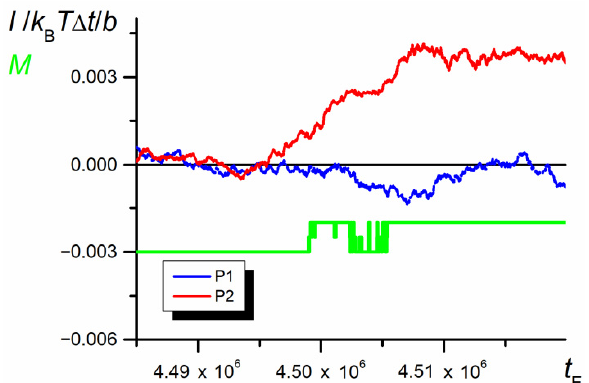
Figure 16. Impulses of forces caused by changes in the free energy exerted by both part P1 and P2 of the chain ( N = 100, ε PP / k B T = − 1 and 0 for P1 and P2, respectively, D = 3 b ). The chart is based on the data recorded at each elementary step.